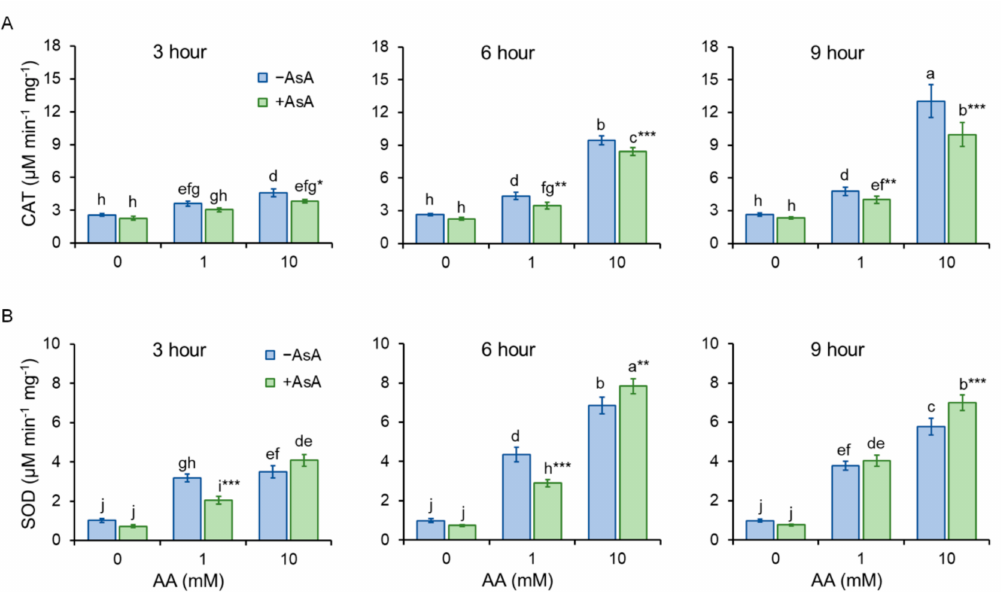
Figure 6. Activity of the antioxidant enzyme system catalase (CAT) and superoxide dismutase (SOD). The antioxidant capacity of cells was determined via detection of antioxidant enzymes activity CAT ( A ) and SOD ( B ). AsA pre-treatment significantly improved AA-altered antioxidant capacity of cells. Bars represent mean ± SD of 4 individual samples. Statistical significance is determined by Duncan’s post-hoc test, different letters above bars indicate statistical difference as p < 0.05 *, 0.01 **, 0.001